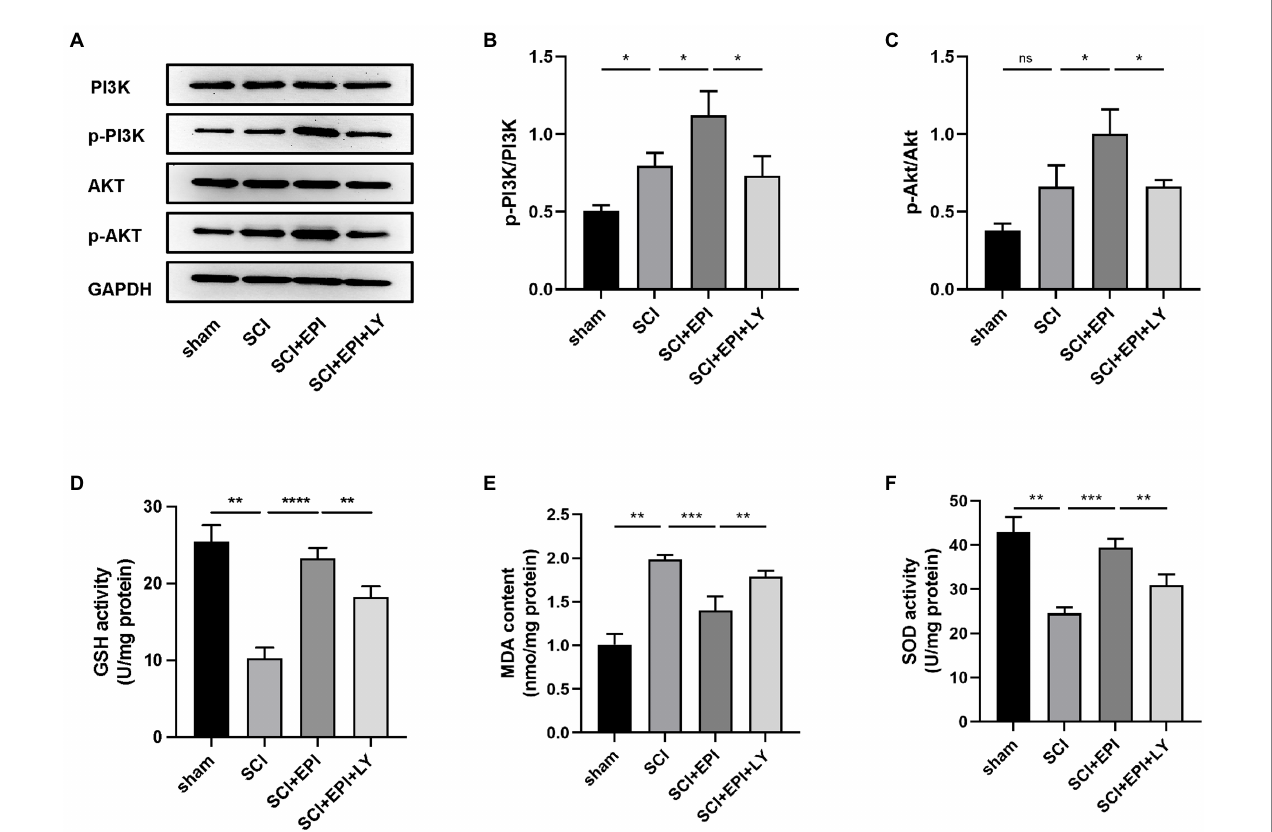
FIGURE 8 Investigation of the PI3K/AKT signaling pathway in the antioxidant effect of EPI (N = 3 per group). (A) The expressions of PI3K, p-PI3K, AKT, and p-AKT were detected by Western blot assays. (B,C) Quantitative analysis of western blot assays. (D–F) The concentration of GSH, MDA, and SOD in sham group, SCI group, SCI + EPI group, and SCI + EPI + LY. * means p < 0.05, ** means p < 0.01, and *** means p <